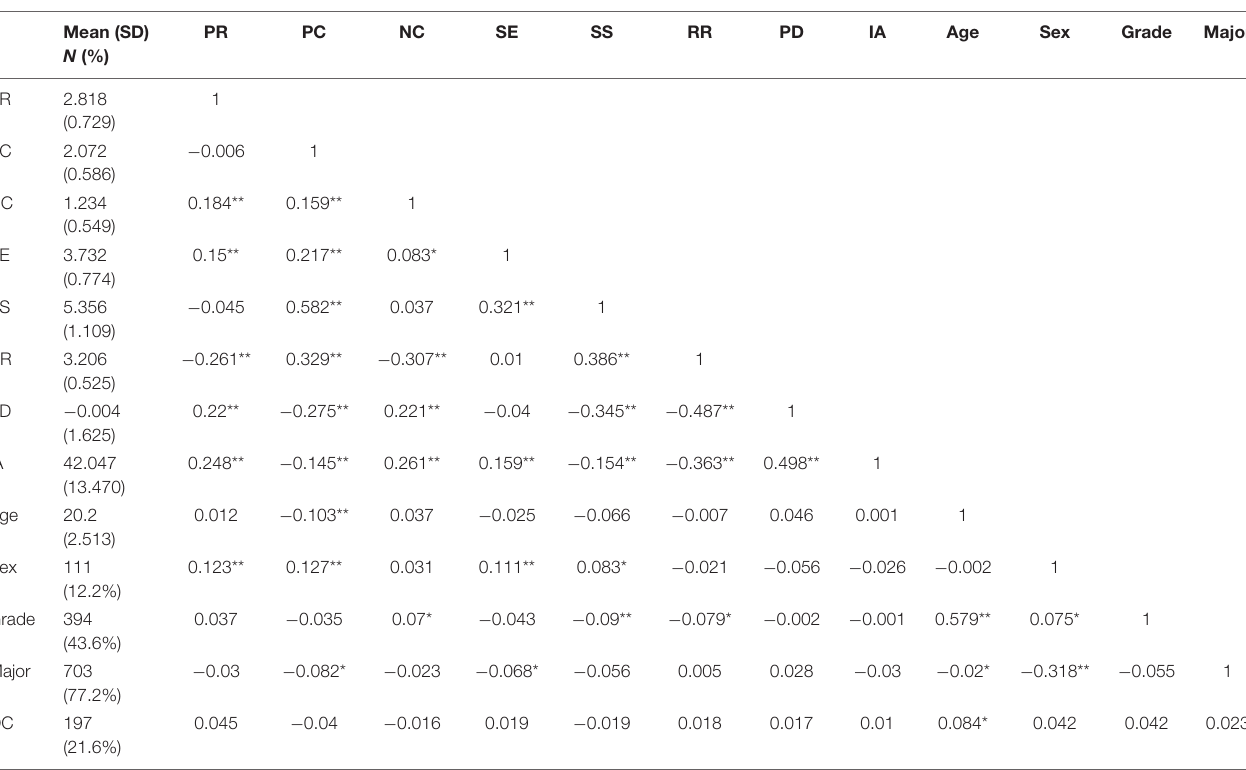
FIGURE 1 | The conceptual diagram of the parellel mediation model. TABLE 1 | Mean, standard deviation (SD), and bivariate correlation between analyzed